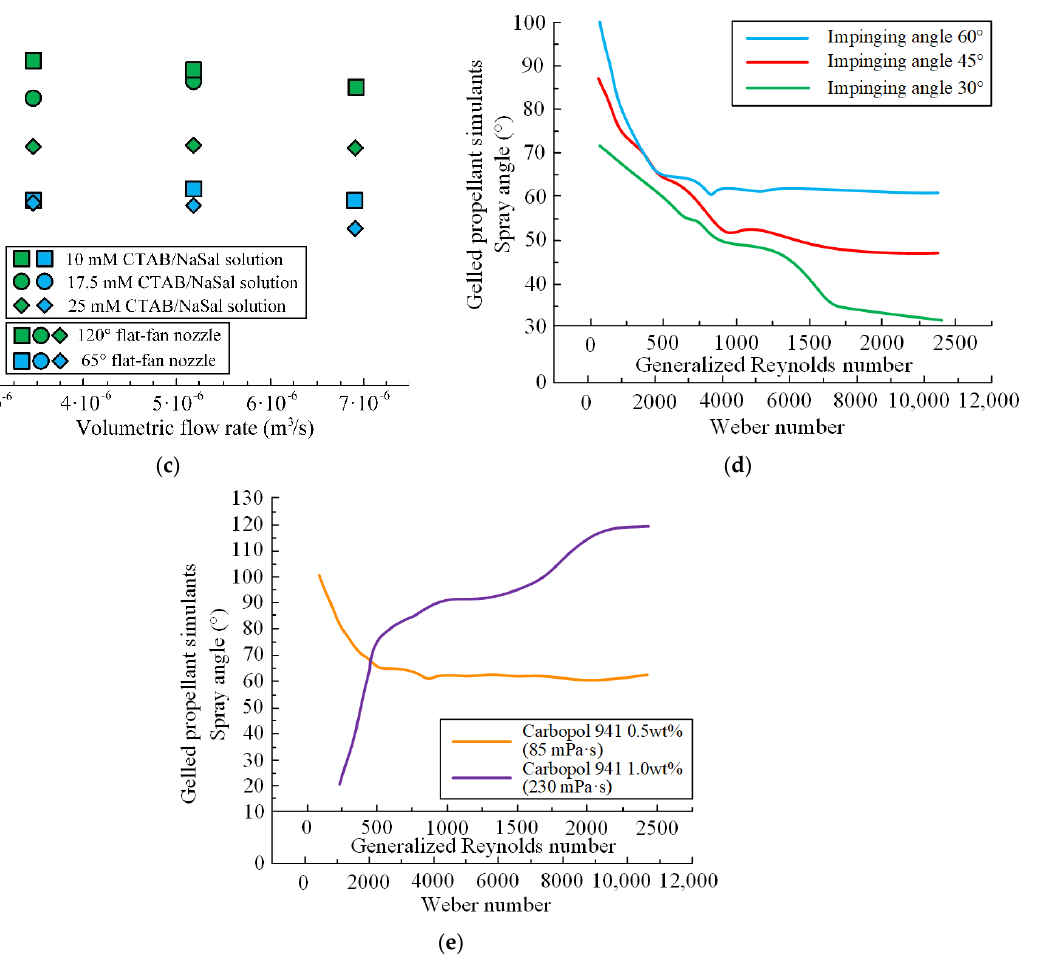
Figure 14. Spray angle versus: ( a ) Momentum flux ratio [95,99]; ( b ) Injection pressure [148]; ( c ) Volumetric flow rate [173]; ( d , e ) Weber and Reynolds numbers [68].